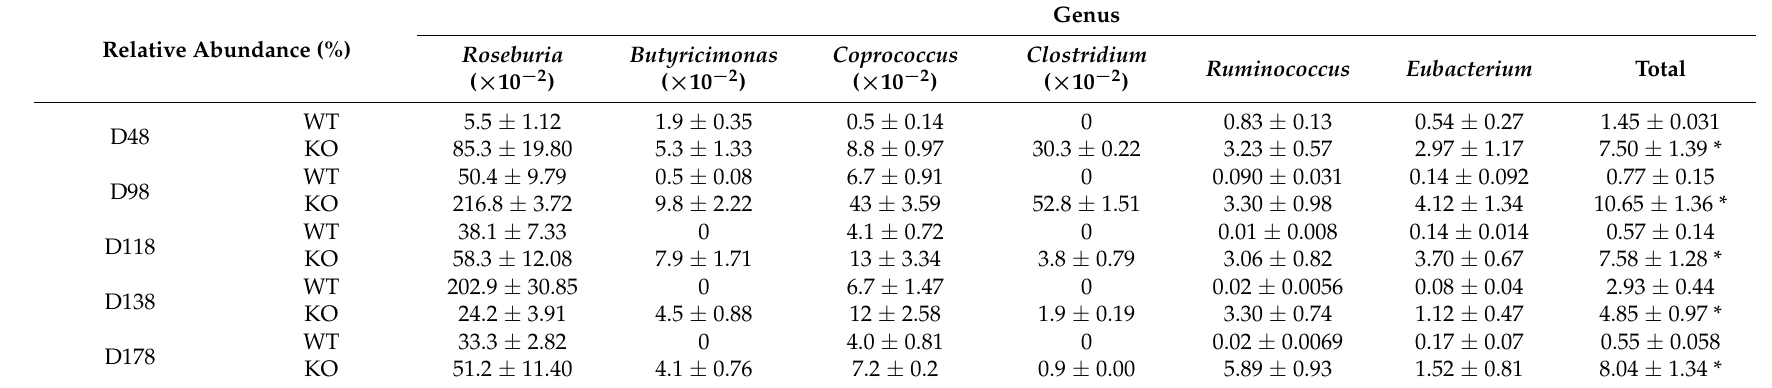
Table 1. Relative abundance of butyrate-producing bacteria.